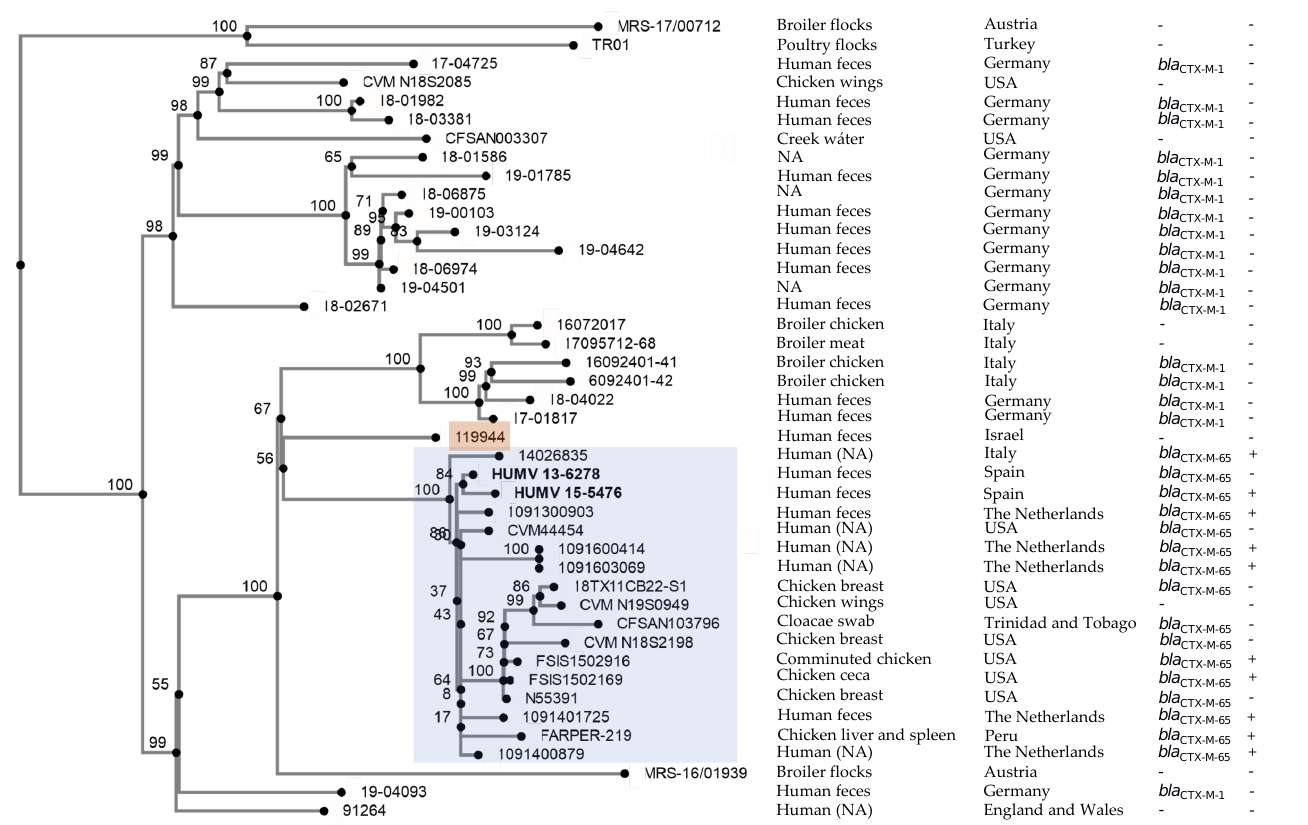
Figure 2. Phylogenetic position of Salmonella enterica serovar Infantis HUMV 13-6278 and